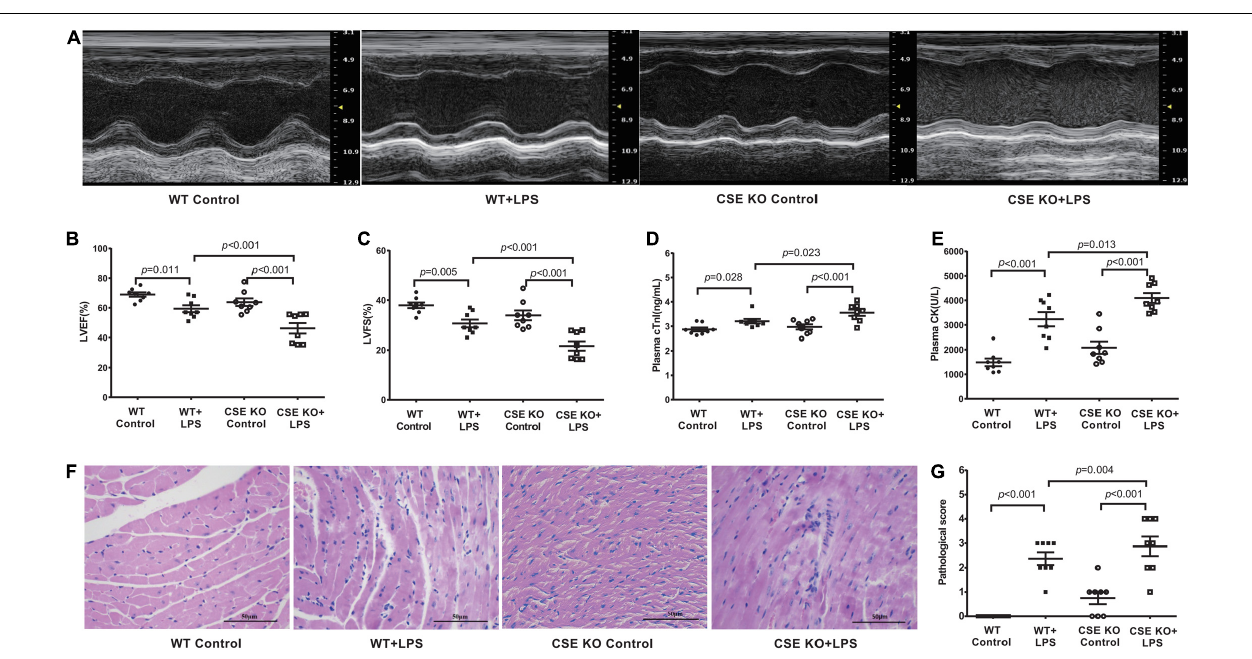
plasma levels of cTnI and CK ( Figures 4A–E ). HE staining in the LPS + NaHS groupalso showed less cardiomyocyte injury and inflammation ( Figures 4F,G